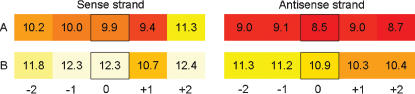
Probe set layout for Affymetrix 100K chip. Each SNP is assayed with 20 perfect match 25-mer oligonucleotides. The additional 20 mismatch oligonucleotides are not shown. Both sense and antisense strands are interrogated with 5 features for each allele that differ only at the SNP nucleotide, denoted A and B. The position of the SNP within the 25mer features is shifted from the central nucleotide (boxed, “0”) by 1 or 2 nucleotides in either direction. For this SNP (rs836702), and sample (NA11994) allele B has a stronger normalized hybridization signal, as indicated by the lighter color and higher hybridization values for most probes. Generally the central base and a particular strand have more discrimination specificity. The genotype for this individual was called as BB with full and all reduced probesets. This is clear when many other samples are tested such that the range of intensity categories is known.